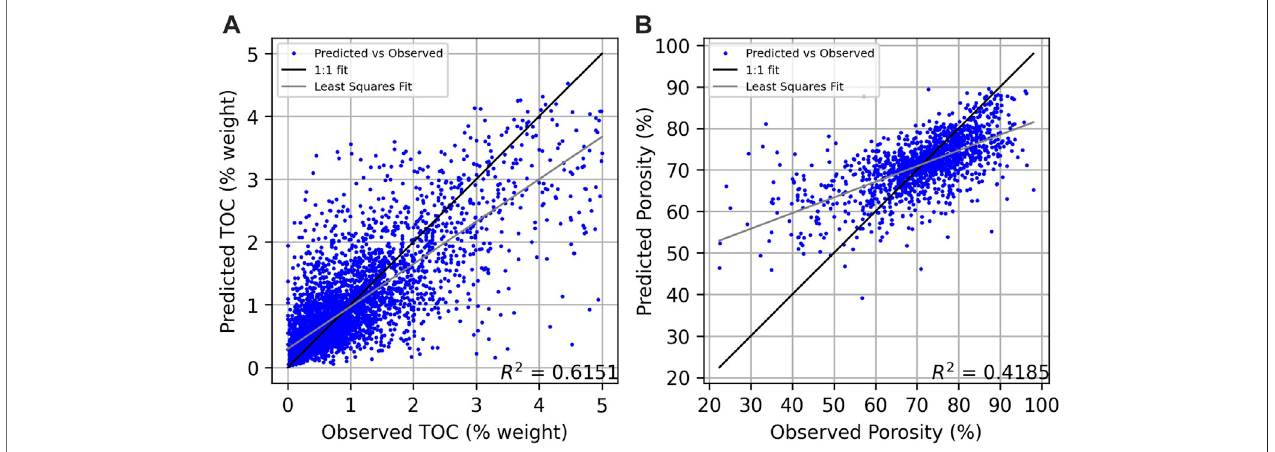
FIGURE 2 | Validation plot of (A) observed TOC values versus predicted TOC values for the k-nearest neighbor model (k = 5) and (B) observed porosity values versus predicted porosity values for the random forest model using 100 trees and a minimum samples per leaf of 3. The 1:1 fi t line shows where observed values match the predicted values. The least squares regression fi t of the model is depicted by the gray